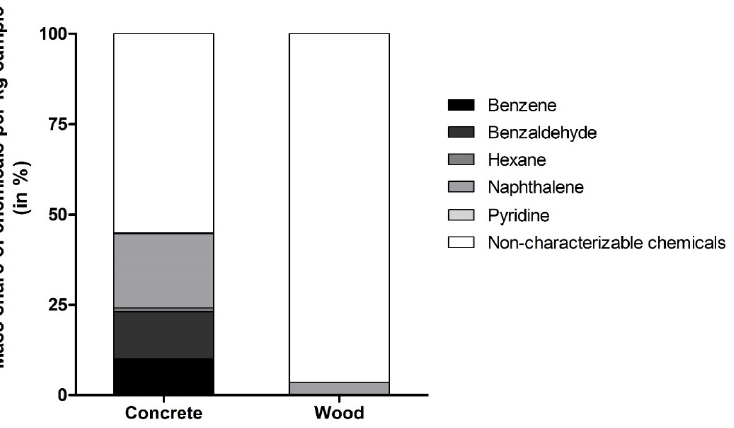
Figure 5. The average mass share (in %) of identified and characterized chemicals per kg building material. In concrete, 45% of the identified chemicals could be characterized, including 21% naphthalene, 13% benzaldehyde, 10% benzene, 1% hexane and <1% pyridine. In the wood samples, only naphthalene could be characterized, which comprised 4% of the identified